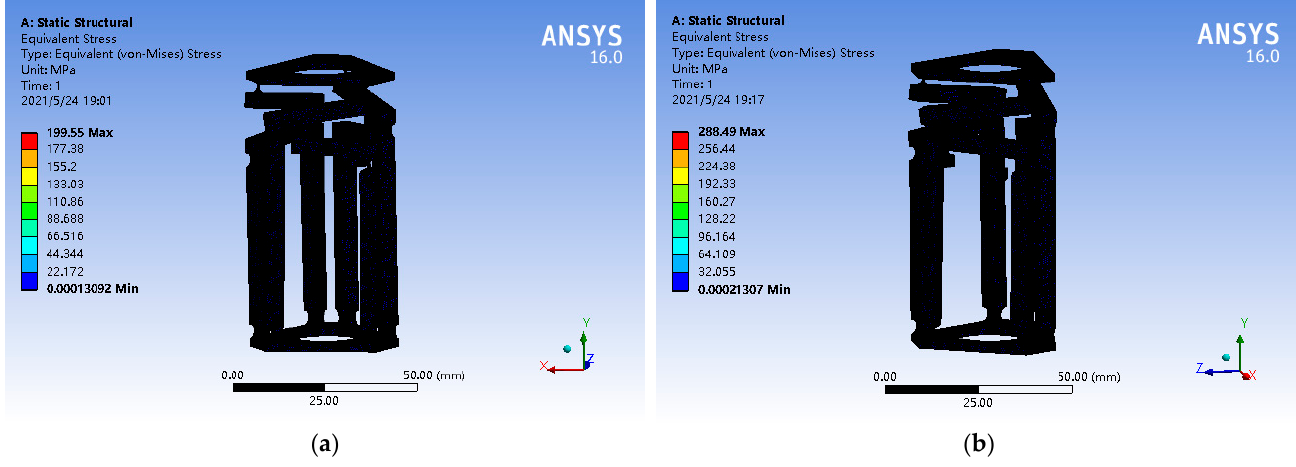
Figure 8. Static simulation of maximum stress value. ( a ) Three branches chain loaded displacement of 30 μ m; ( b ) three branches chain loaded thrust of 50 N.